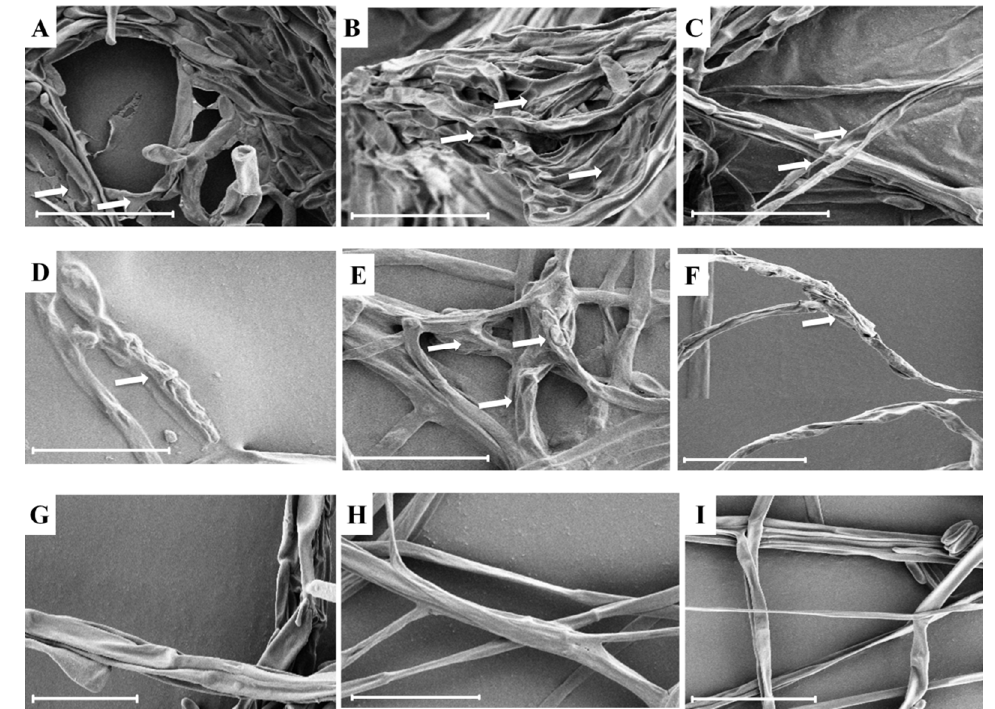
Figure 6. Scanning electron micrographs of ( A , D , G ) F. moniliforme , ( B , E , H ) F. subglutinans and ( C , F , I ) F . temperatum ( A – C = treated with strain KNU17BI2, D – F = treated with strain KNU17BI3, G – I = untreated control), (scale bars: 20 µ m). ( A ) White arrows denote shrinked, deformed and/or lysed fungal structures.